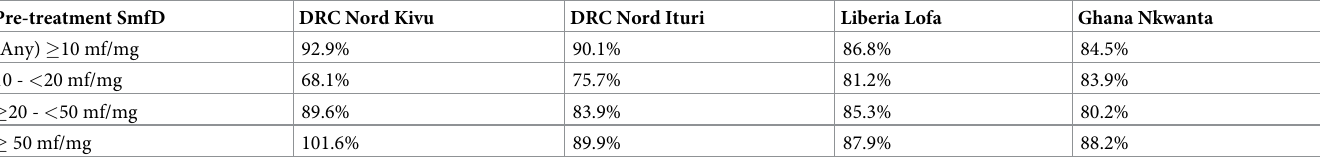
Table 3. Treatment difference 12 months post-treatment by study area across and by intensity of infection.